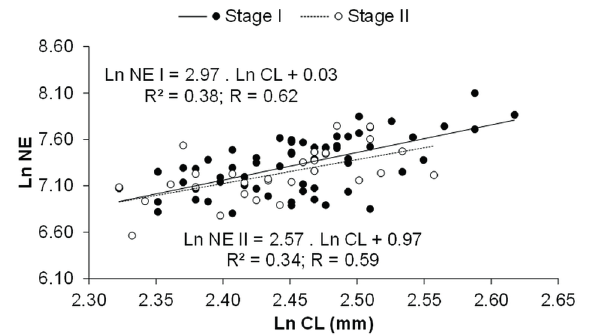
Figure 2. Nematopalaemon schmitti (Holthuis, 1950). Best fit model between ln number of embryos (NE) and ln carapace length (CL) (I = initial embryonic development, II = final embryonic development).